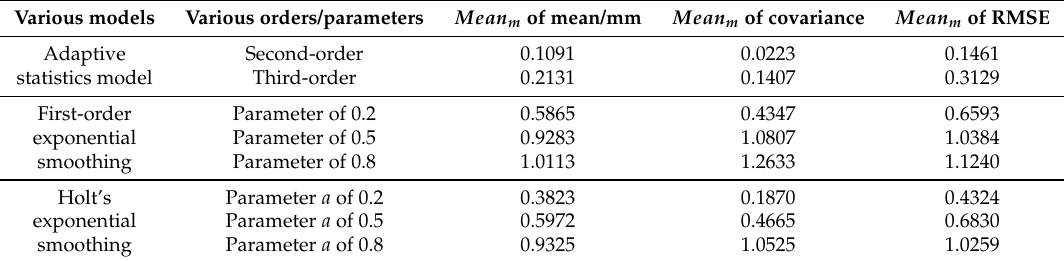
Table 4. The results by several kinds of online denoising